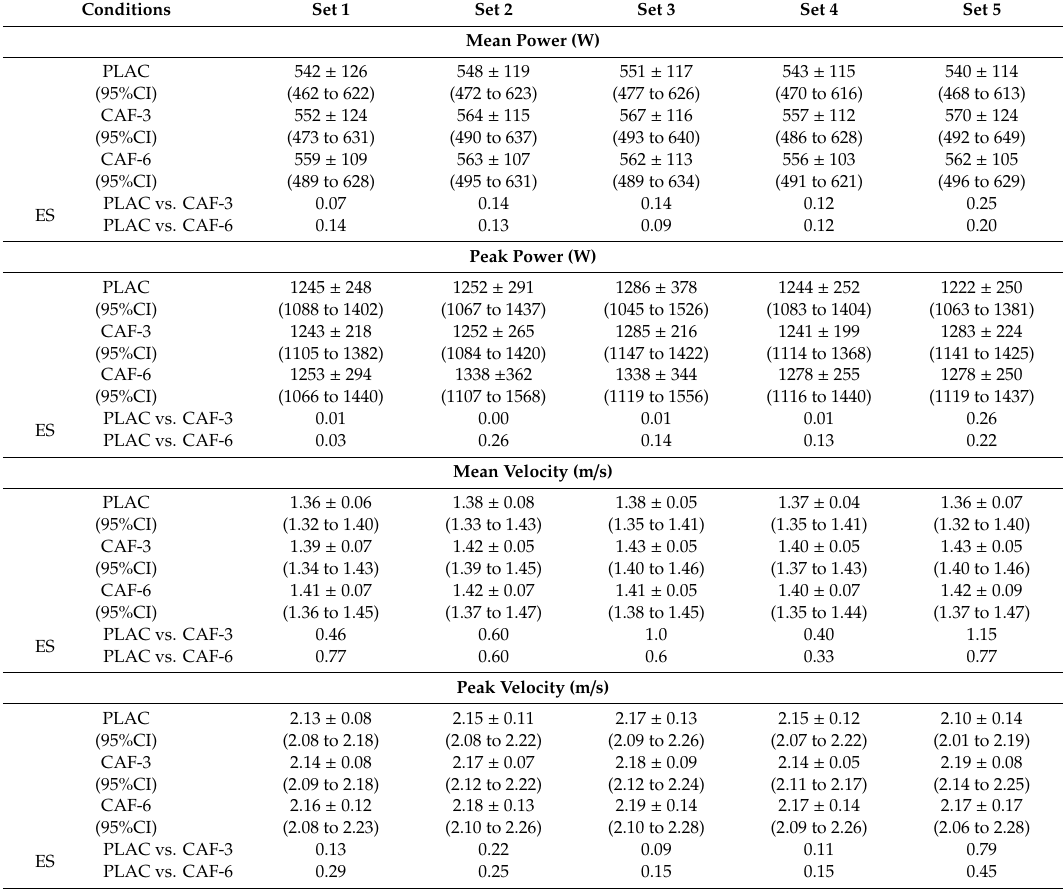
Table 2. Power output and bar velocity during 5 sets of the bench press throw with the ingestion of 3 and 6 mg / kg / b.m. of ca ff eine or with a